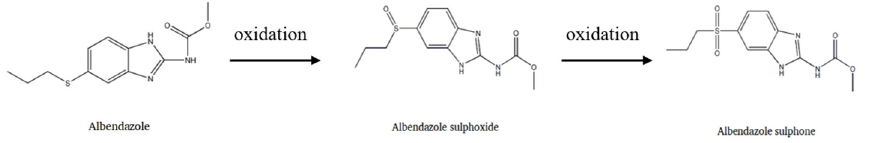
Figure 1. Albendazole metabolic pathway.